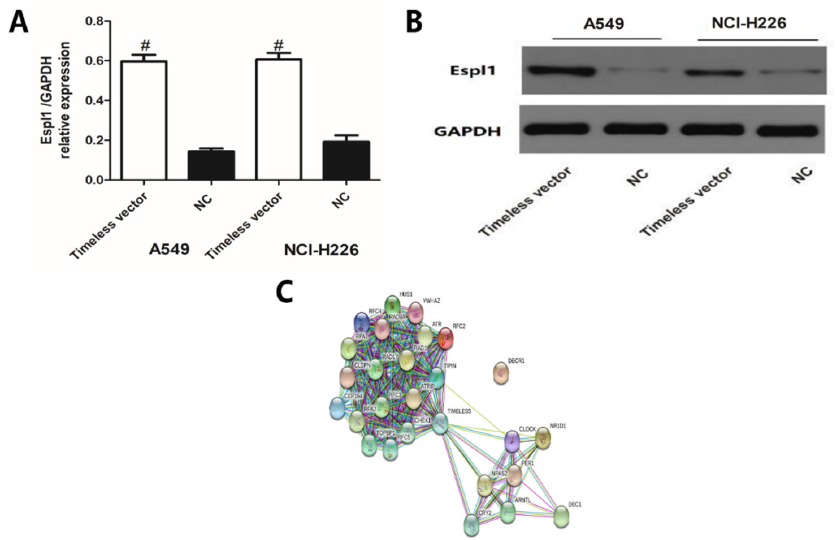
Figure 8. ( A , B ) ESPL1 expression at mRNA and protein levels in the A549 and NCI-H226 cells after 48 h of transfection with the Timeless expression vector or the NC vector. ( C ) Protein–protein interaction network for the Timeless gene and the 25 most frequently altered neighbor genes in both squamous cell lung carcinoma and lung adenocarcinoma using the STRING database. NC, negative control; ESPL1, extra spindle pole bodies like 1. # p < 0.05 vs. negative control.